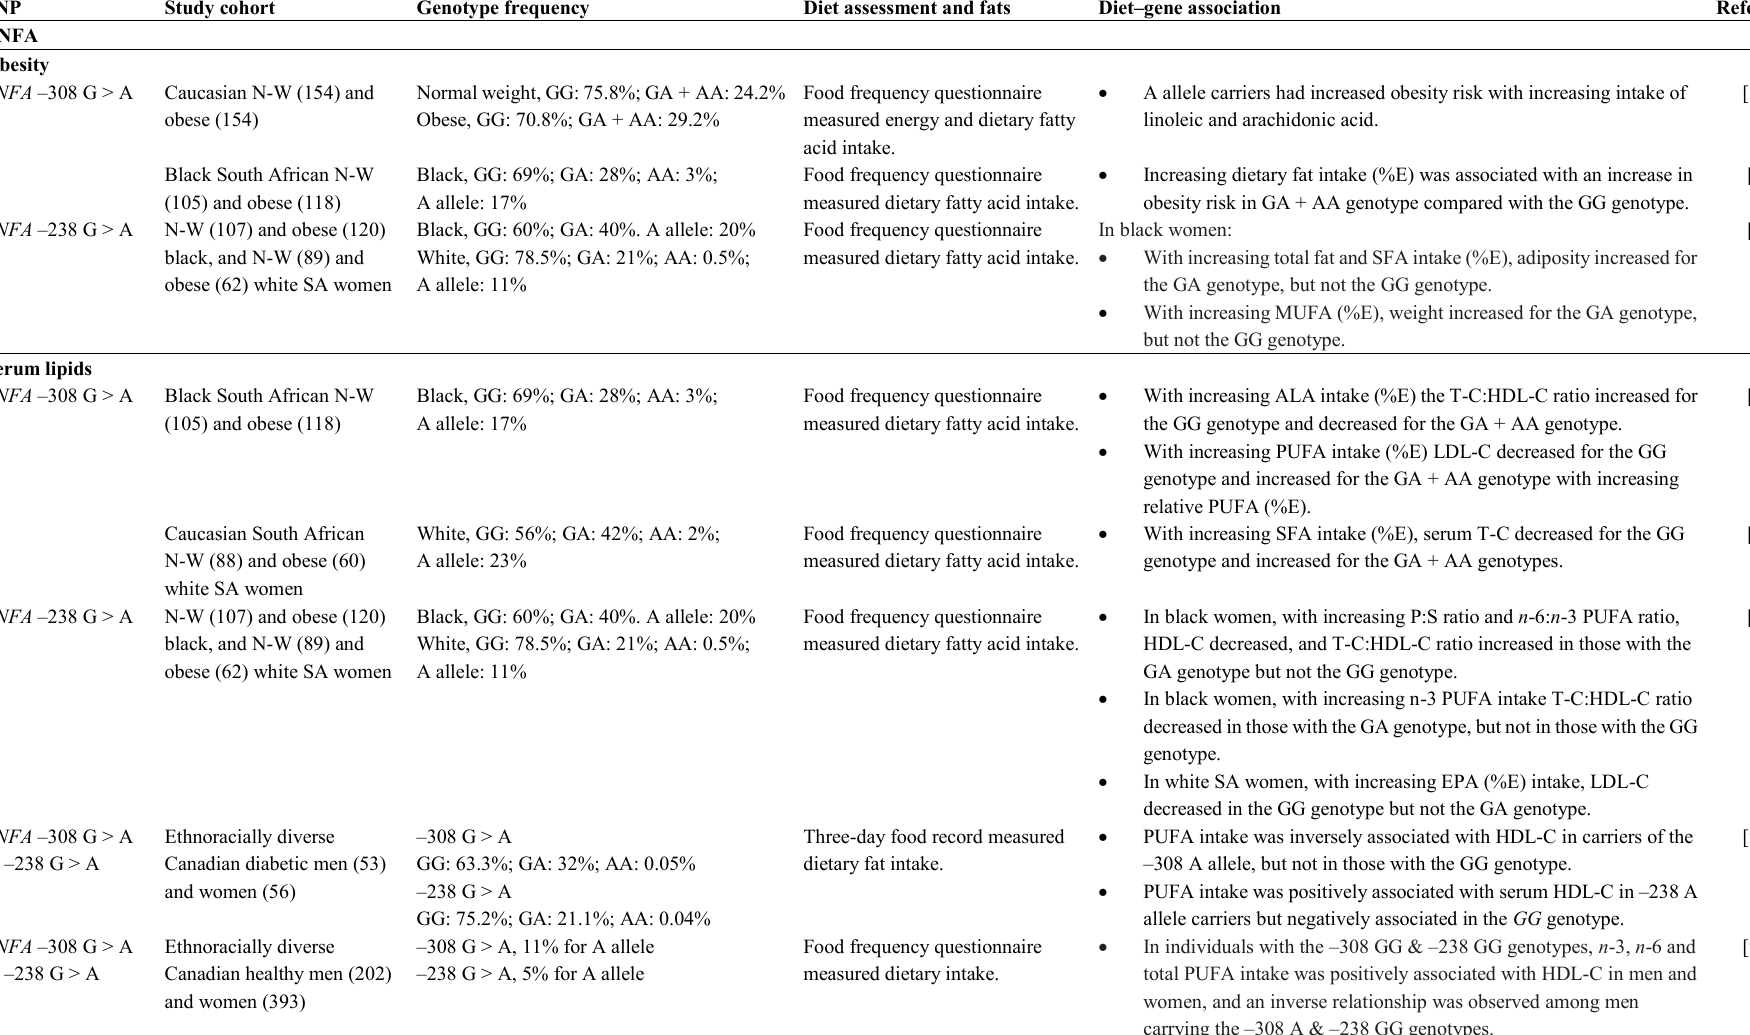
Table 3. Diet–gene interactions between TNFA and IL-6 single nucleotide polymorphisms and dietary fat intake on obesity and serum lipids